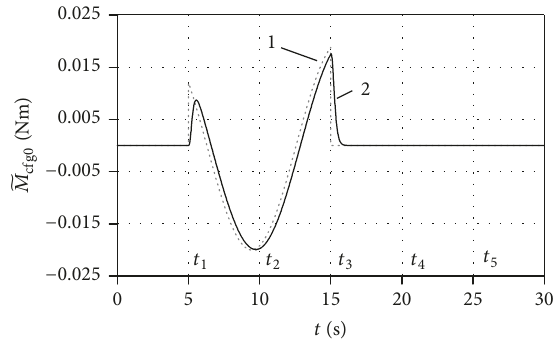
̃𝑀 value by proposed FI cfg 0